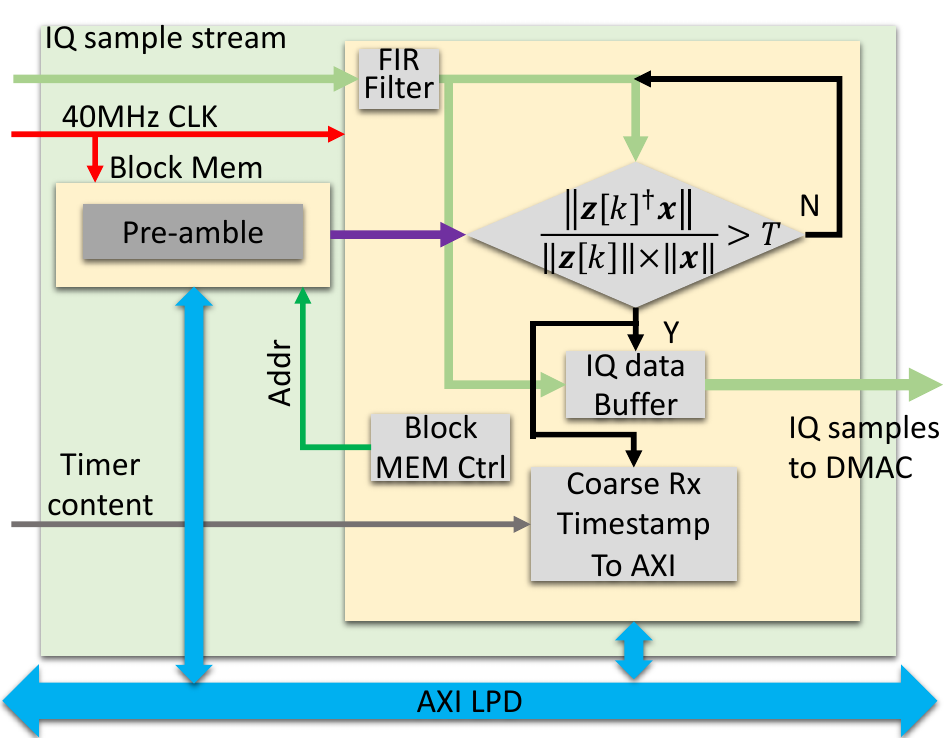
Figure 16. Receive engine block